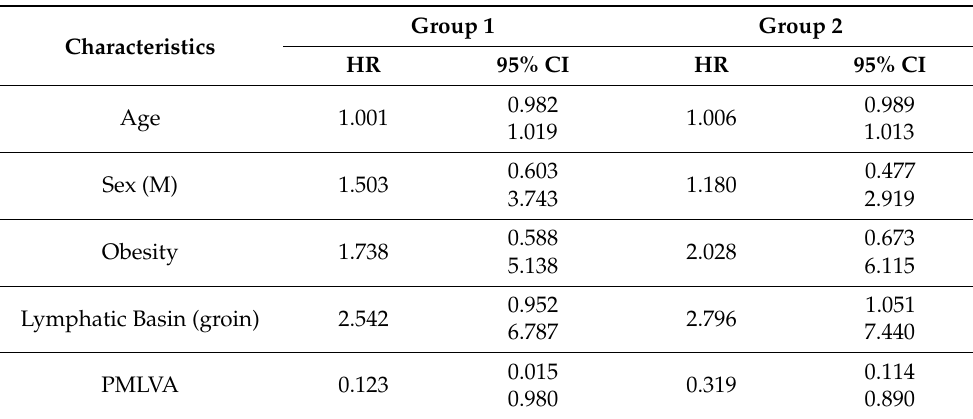
Table 3. Multivariate Cox proportional hazards regression models. Comparison among the